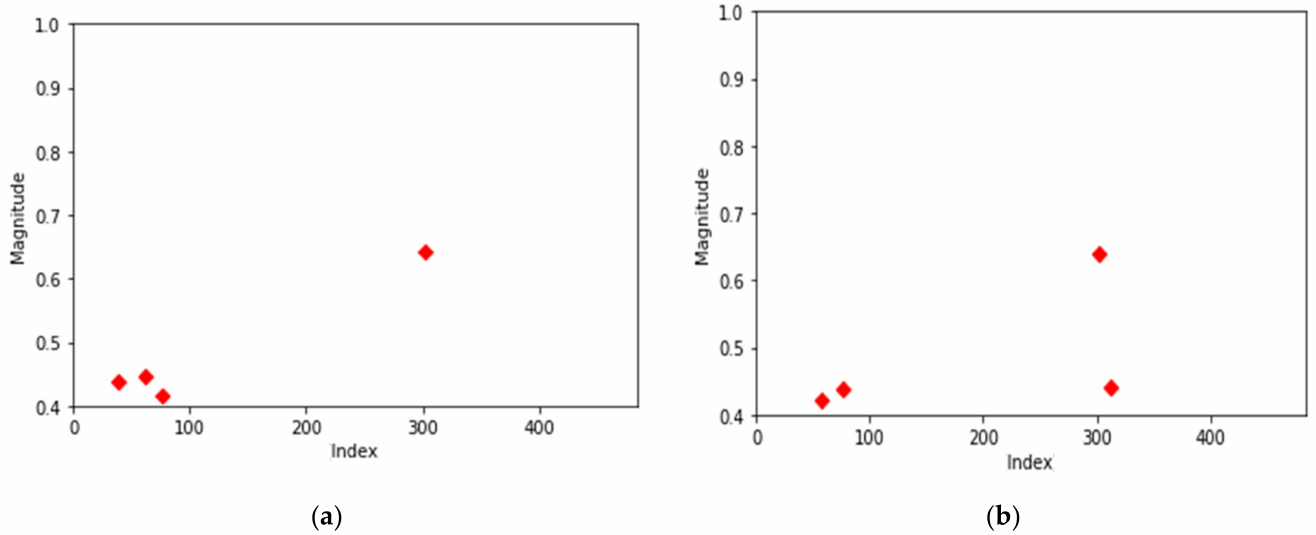
Figure 6. Center points of two most common first-order error data. ( a ) Center points of first-order error data (most common data); ( b ) center points of first-order error data (second common data). After the analysis of 1st-order error data, the distribution of the center point of the 2nd-order error data was